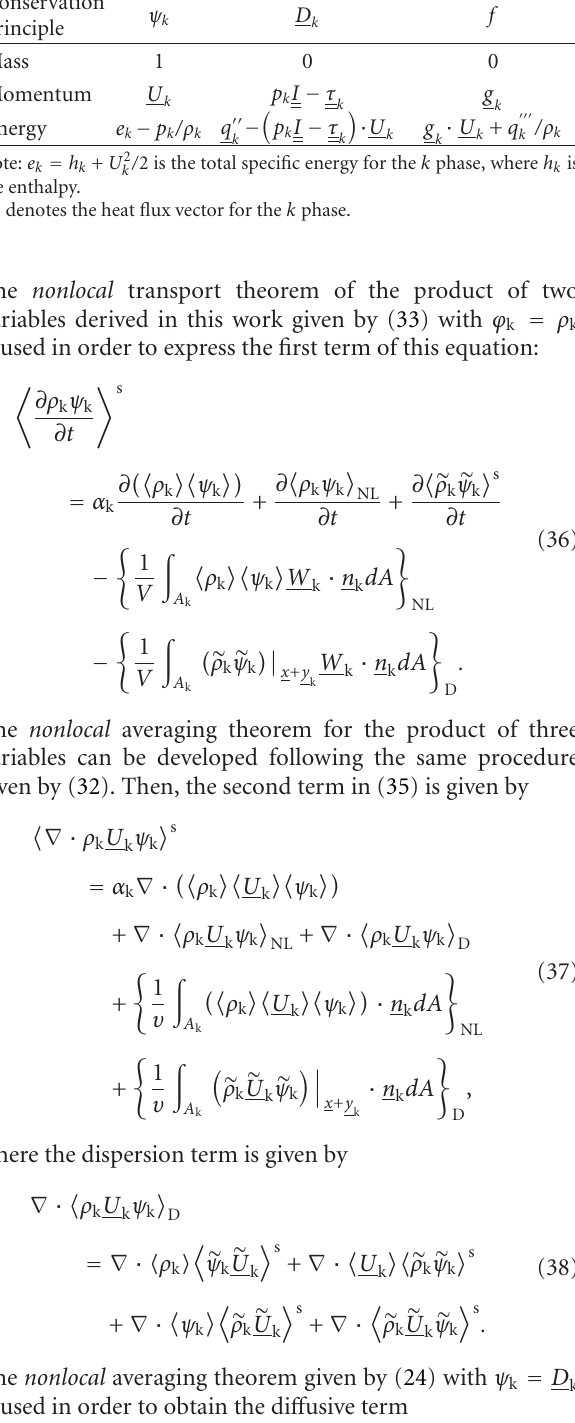
Table 1: Conservation terms.